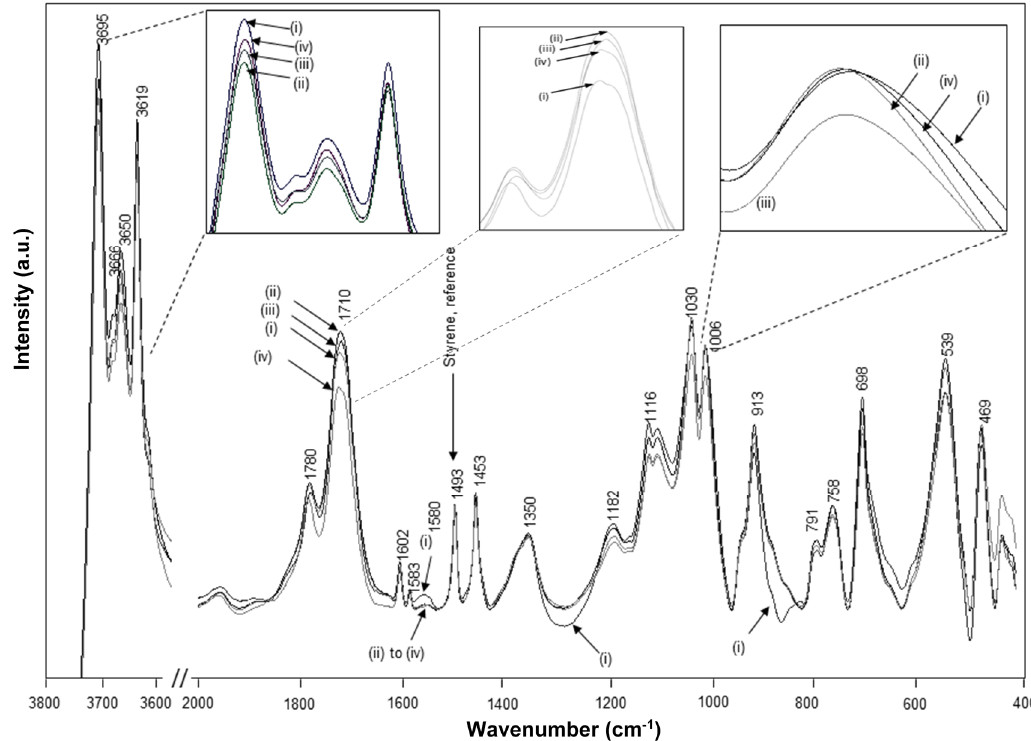
Figure 13. FTIR spectra of chemically reacted Kln/SMI = 70:30 after thermal annealing at different temperatures, ( i ) non-annealed, ( ii ) 135 °C, ( iii ) 150 °C, ( iv ) 180